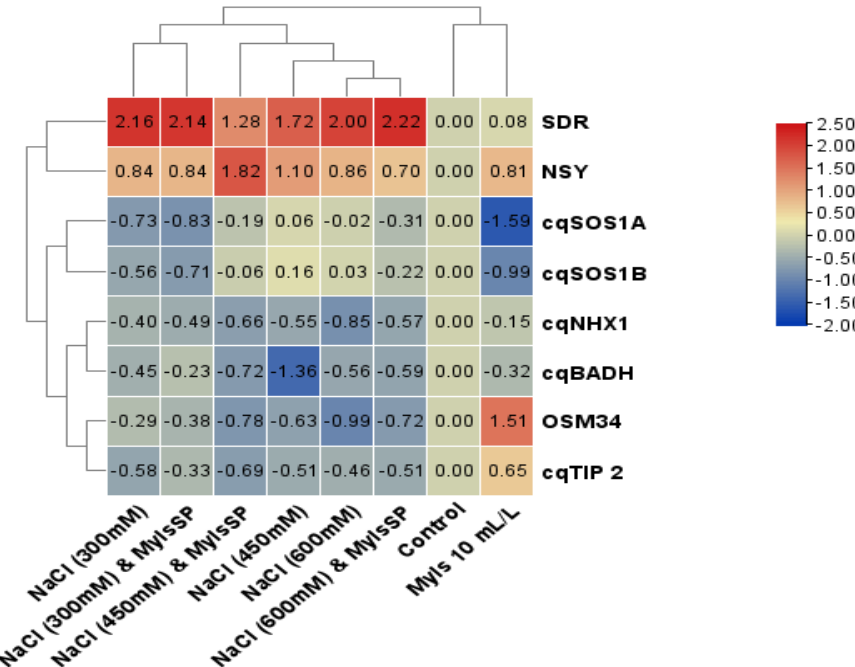
Figure 10. Transcriptomic patterning and gene expression of salinity-stressed proteins and genes involved in ABA and glycine betaine biosynthesis in Quinoa ( Chenopodium quinoa L. var. Giza1). Genes involved are osmotin-like protein (OSM34); sodium/proton exchanger (Na/H + ) (NHX1); salt overly sensitive 1A (SOS1A); salt overly sensitive 1B (SOS1B); betaine aldehyde dehydrogenase (cqBADH); tonoplast intrinsic protein 2 (TIP2); neoxanthin synthase (NSY); and (H) short chain- dehydrogenase/reductases (SDR).